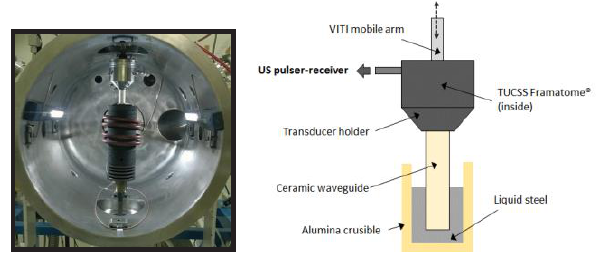
Fig. 3. The VITI facility.